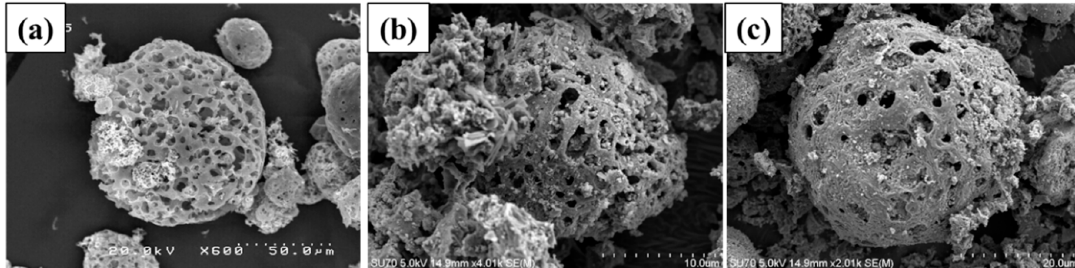
Figure 7. SEM photographs of ( a ) raw ash, ( b ) Product-K 2 S obtained at 300 °C, and ( c ) Product-KOH at 300 °C.